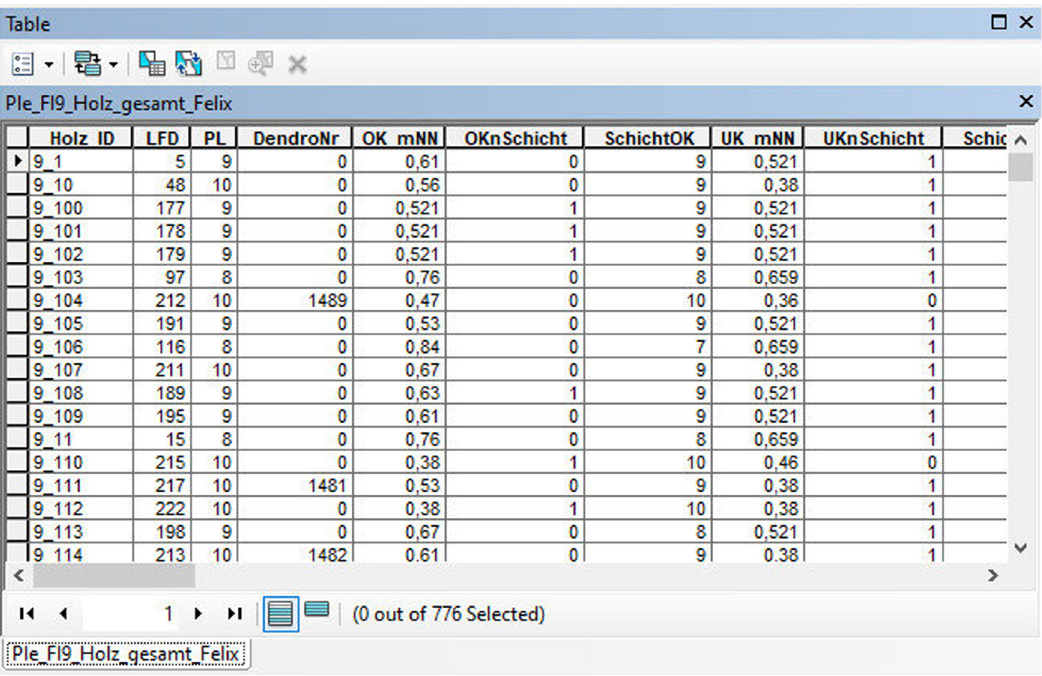
Figure 7: Extract of the attribute table of the shape fi le containing wooden features ( Graphics: F. Rösch )